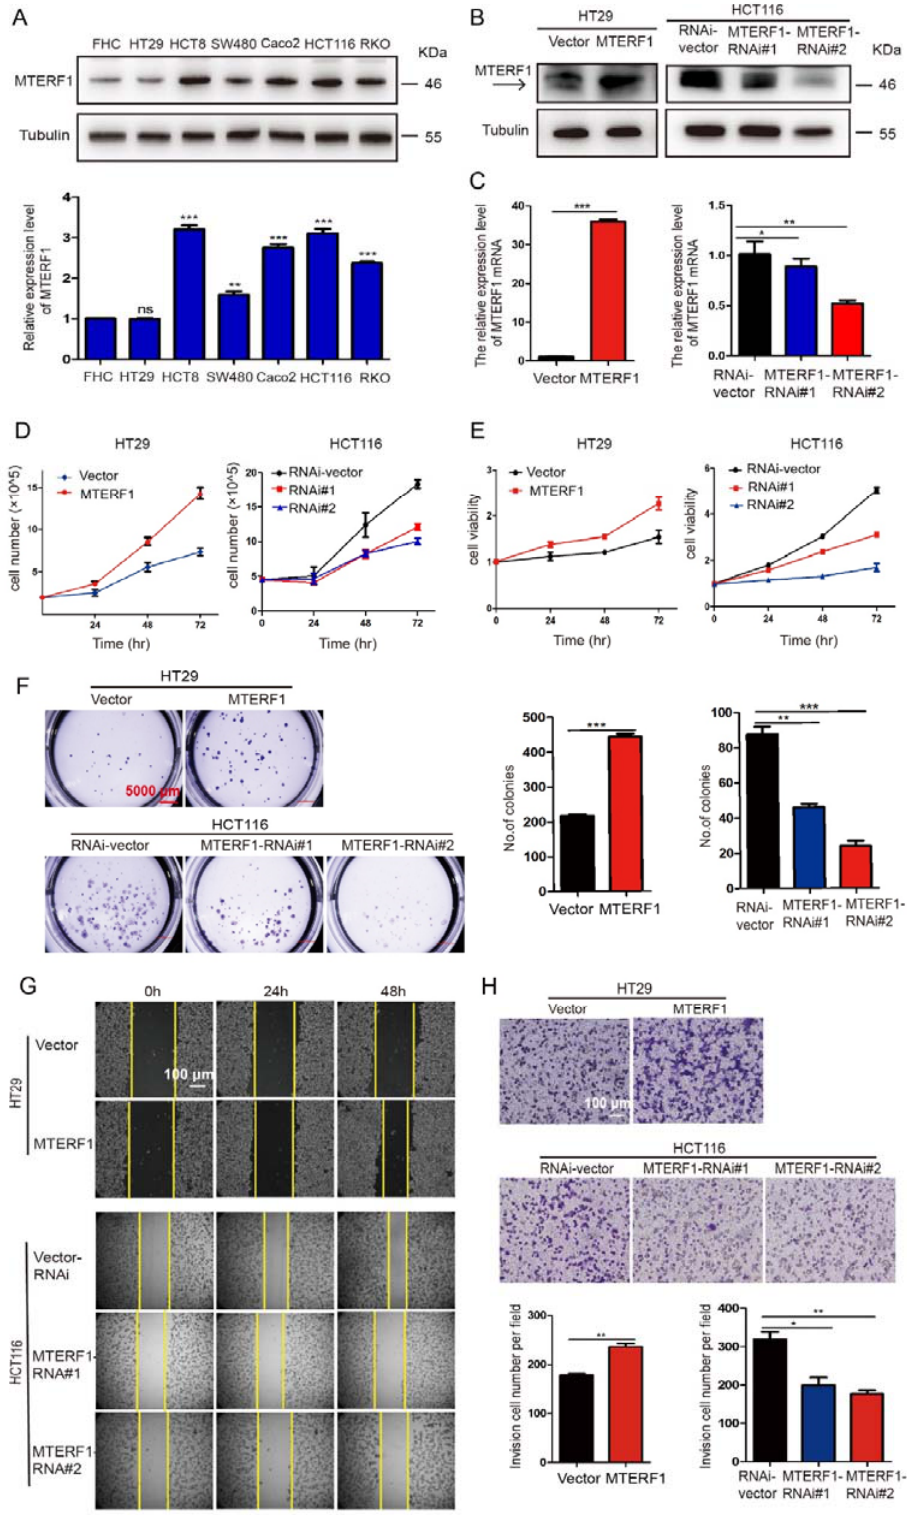
Figure 2. MTERF1 promotes CRC cell proliferation, migration, and invasion. ( A ) Relative MTERF1 protein expression in different colorectal cell lines: normal human colorectal mucosal cell (FHC) and colorectal cancerous cell lines (HT ‐ 29, HCT ‐ 8, SW480, Caco ‐ 2, HCT116, and RKO). ( B , C ) Efficiency of MTERF1 overexpression in HT ‐ 29 cells and individual MTERF1 ‐ shRNA knockdown in HCT116 cells verified by Western blotting ( B ) and real ‐ time PCR ( C ). Vector: pCDH; MTERF1: MTERF1 ‐ pCDH. α‐ Tubulin was used as an internal control, and RNAi ‐ Vector was used as a scramble shRNA